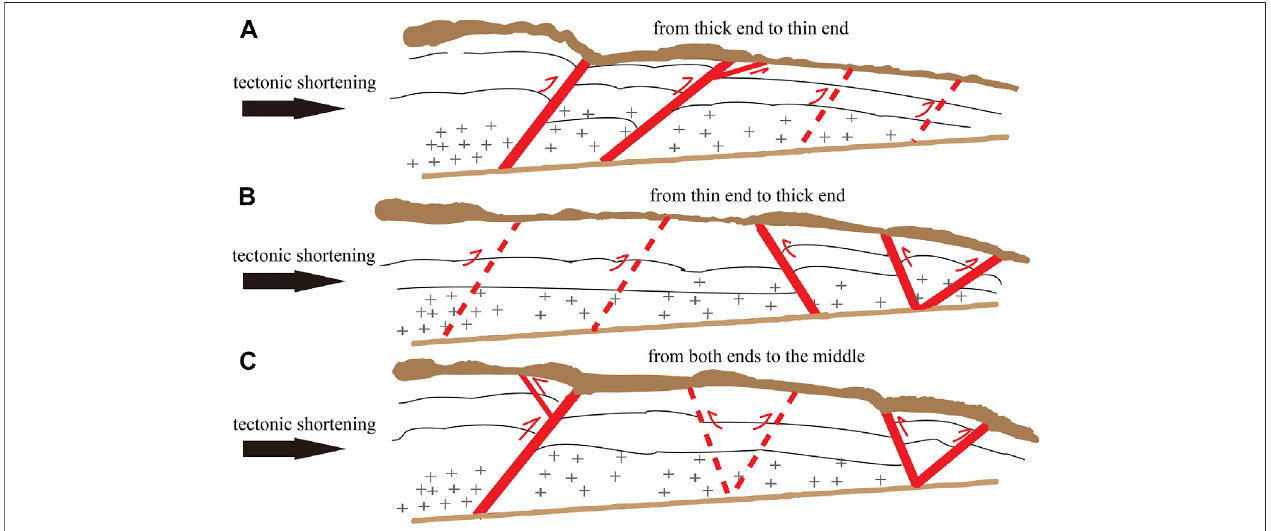
FIGURE 13 | Three potential spatiotemporal migration patterns of fold-and-thrust belts and topography, manifesting in a decollement wedge 2D setting based on our numerical models. (A) Pattern 1: deformation migrating from thick end to thin end; (B) Pattern 2: deformation migrating from thin end to thick end; (C) Pattern 3: deformation migrating from both ends to middle. In some models, only one pattern manifests [especially archetypal pattern (A) ], whereas, in others, mixes such as (C) seem to be manifesting. Clari fi cations: deformation can mean localized (yet fi nite-width) internal plastic strain and also topographic surface deformation.